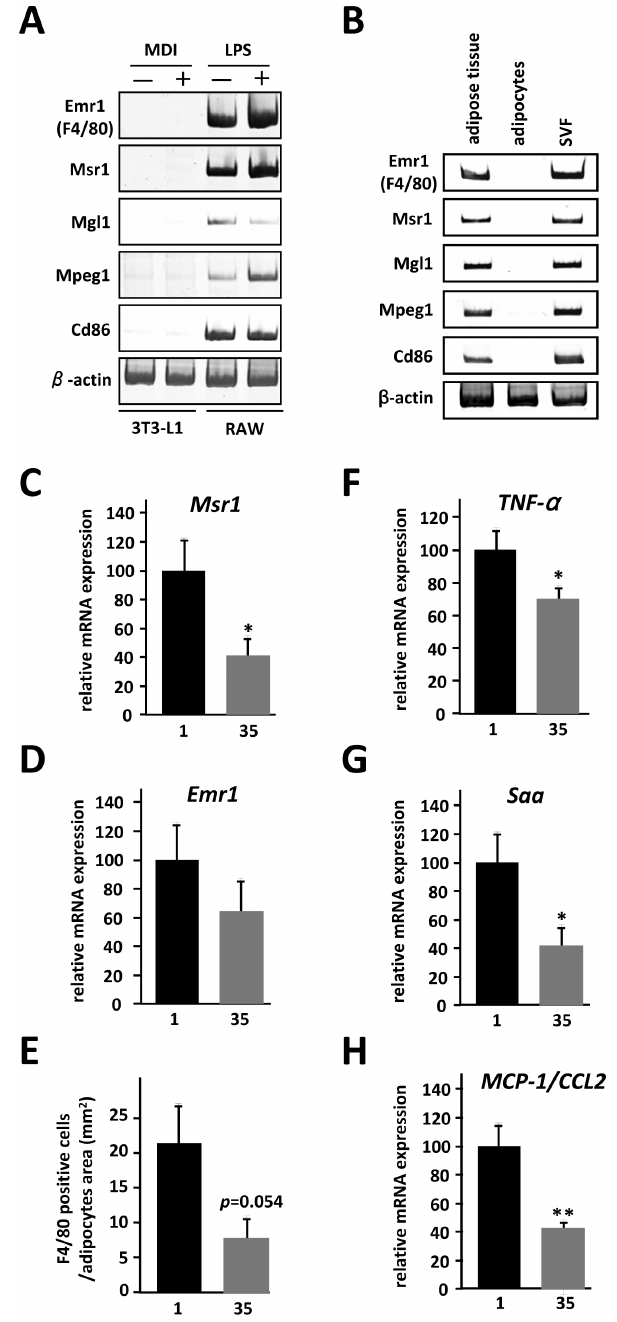
Figure 1. Effects of dietary vitamin B6 on adipose gene expression in HFD mice. A , B , Semiquantitative RT-PCR was performed to determine mRNA levels of genes related to macrophages. 3T3-L1 preadipocytes were treated with MDI for 48 h and differentiated into mature adipocytes as described under ‘‘Materials and Methods’’. RAW264.7 cells were stimulated with 1 m g/ml of LPS for 18 hr. Mature adipocytes and SVF were isolated from white adipose tissue of HFD mice as described under ‘‘Materials and Methods’’. The level of Emr1 (F4/80) transcript was used as a control for macrophages. C , D , F–H , Total RNA from individual mice (n=12) in two groups was subjected to quantitative PCR to examine mRNA expression level of selected genes. All values are normalized to b -actin levels. The data (mean 6 S.E.) are representative of three independent experiments. * P , 0.05, ** P , 0.01 compared with those of 1 mg/kg PN ( 1 ). E , The number of